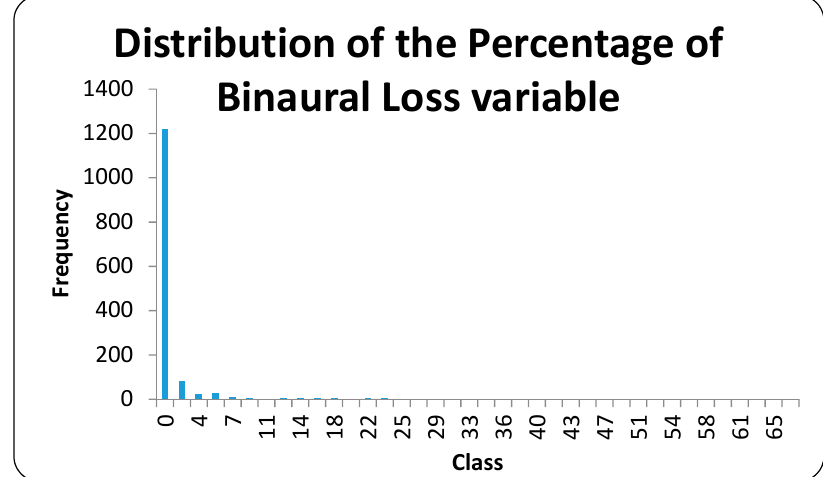
Figure 1. Distribution of the percentage of binaural loss variable. Source: Compiled by authors. The variable was discretized on the following intervals (see Table 1). Table 1. Binaural loss sample distribution. Source: Compiled by authors.